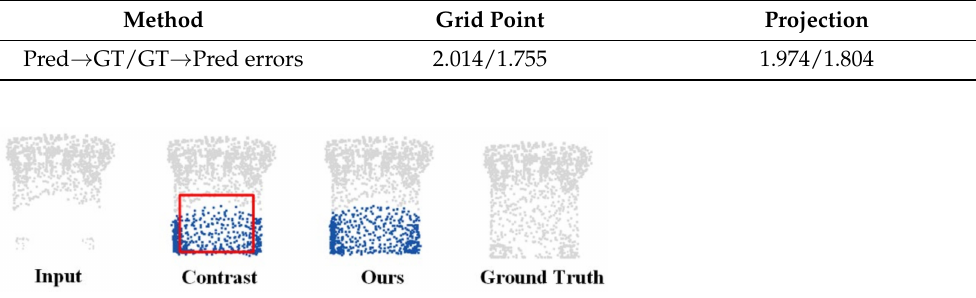
Figure 11. Compared with the projection, the distribution of the point cloud generated based on 2D grid point folding is uniform in the red box. The experimental results show that concatenating the features of a 2D point grid can improve the quality of the completed point cloud. Table 5. Pred → GT and GT → Pred error obtained via grid point and projection as decoder input.